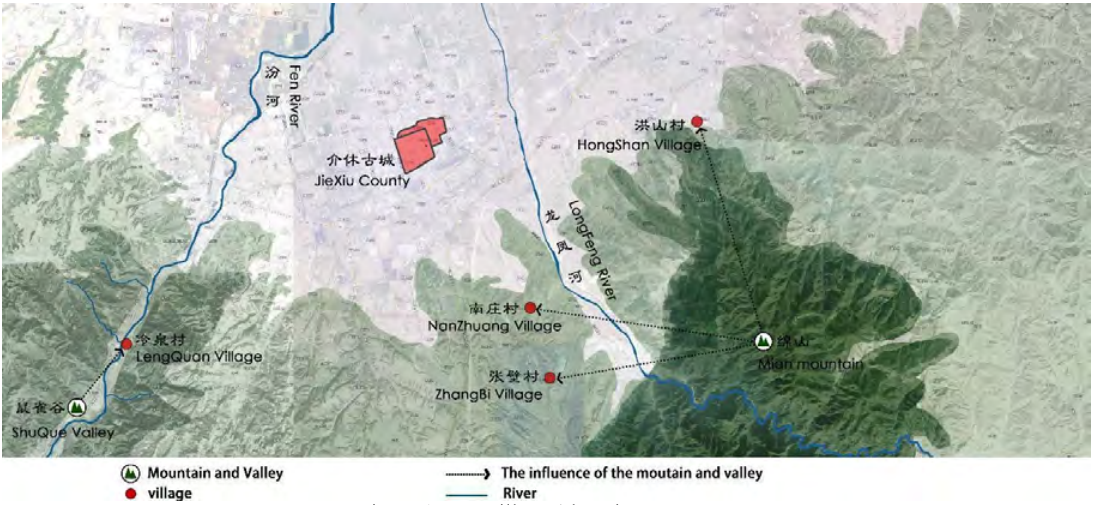
Figure 1 Four villages’